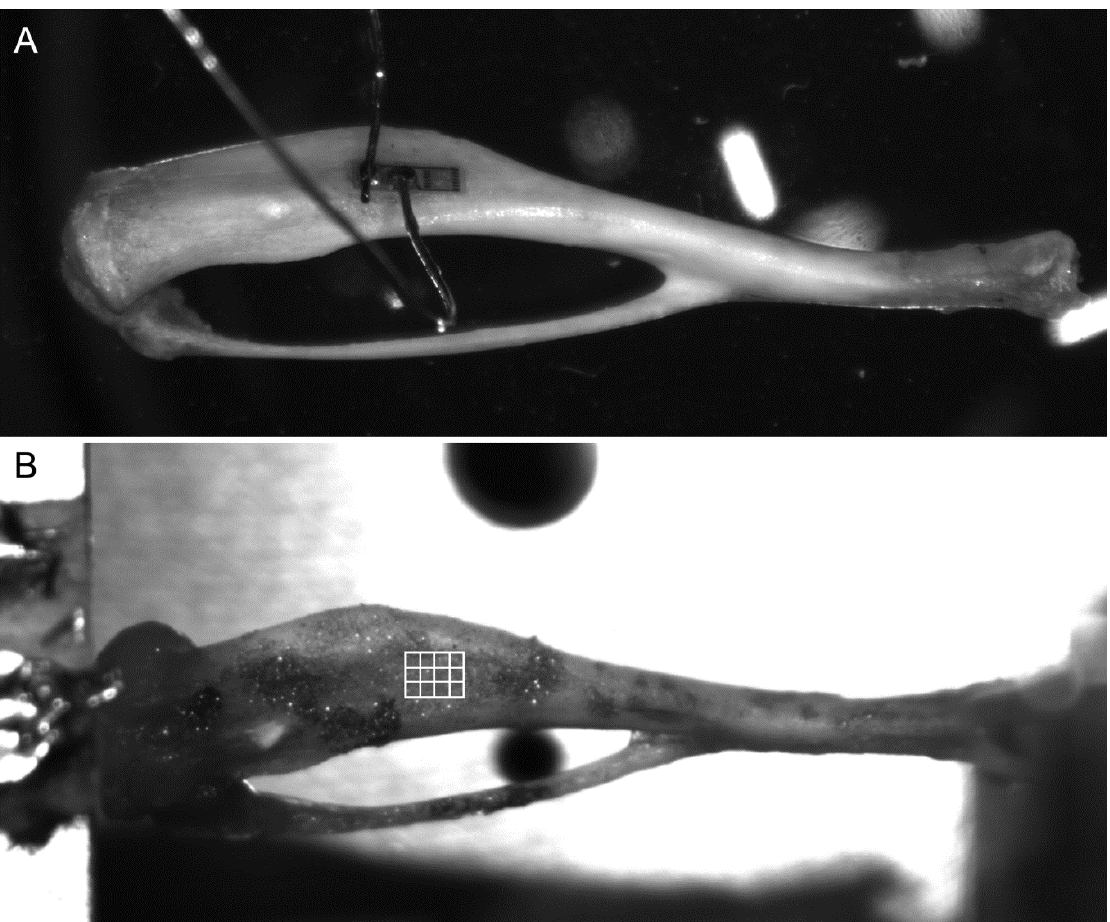
Figure 2. The micro strain gauge was placed on the medial surface of the tibial midshaft ( A ), and the digital image correlation (DIC) region of interest was selected to be as superimposable as possible to the gauge active grid ( B ).